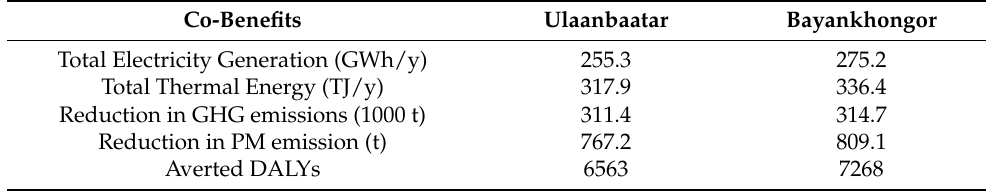
Table 9. Comparison of the expected co-benefits from the combined scenario in UB and Bayankhongor (Estimated by the